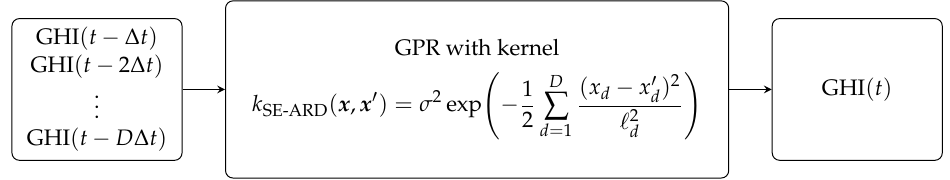
Figure 3. GPR forecasting model based on the SE-ARD kernel k SE-ARD . GHI ( t − ∆ t ) , GHI ( t − 2 ∆ t ) , . . . , GHI ( t − D ∆ t ) is the observation set and ∆ t = 10min is the time step.